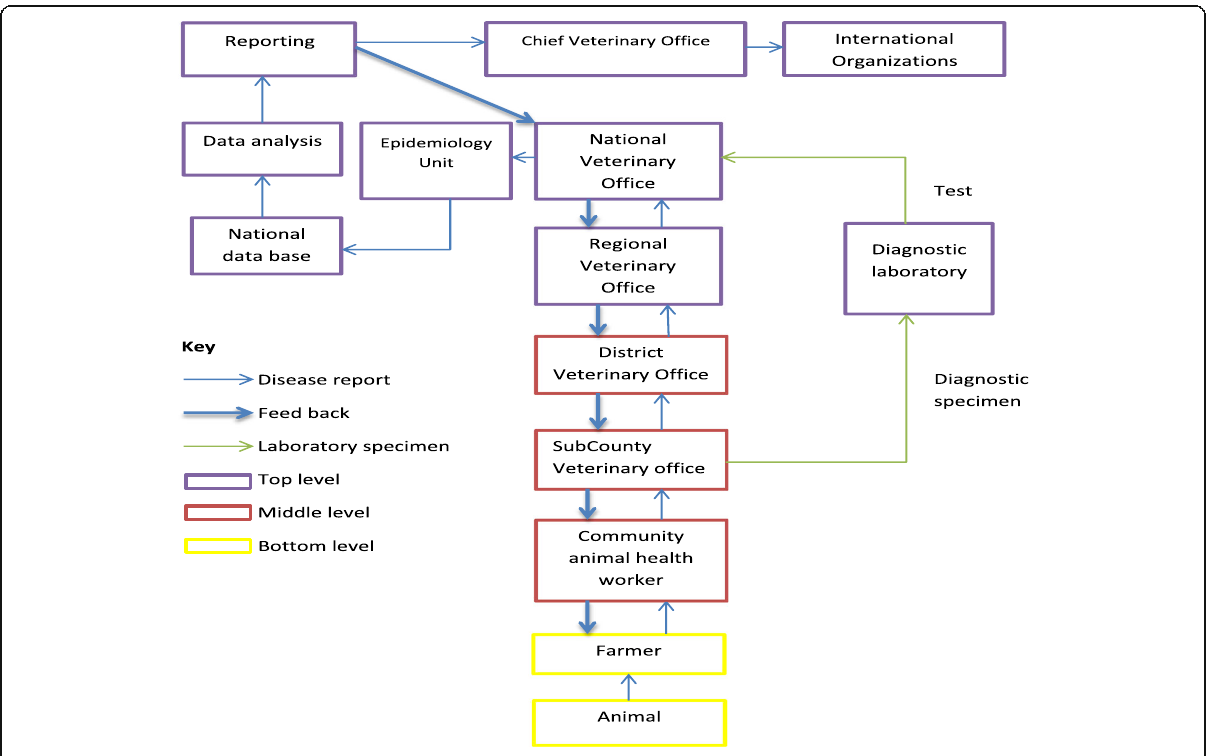
Fig. 1 The stakeholders of the disease surveillance system being assessed and their